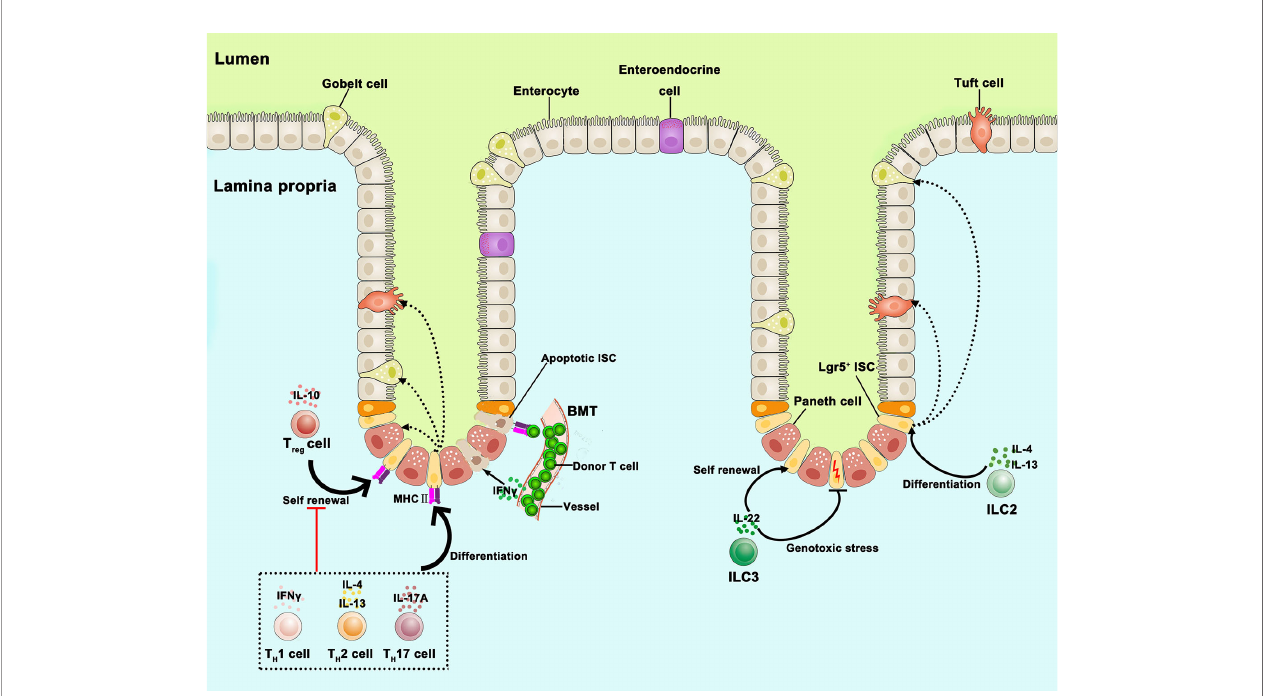
FIGURE 2 | The link between the intestinal stem cells and immune cells. The role of immune cells such as T cells and ILCs, as well as cytokines secreted by these immune cells on the regulation of ISC function. T reg cells (IL-10) promote ISC renewal, while T H 1 (IFN g ), T H 2 (IL-4, IL-13), and T H 17 cells (IL-17A) suppress ISC renewal and promote differentiation; T H 1(IFN g ) and T H 2 (IL-4, IL-13) cells promote speci fi c differentiation toward Paneth cells and tuft cells, respectively; donor T cells (IFN g ) act on ISC by triggering apoptosis in GVHD; MHCII is important for interactions between ISC and T cells. ILC2s (IL-4, IL-13) promote speci fi c differentiation toward goblet cells and tuft cells; ILC3s (IL-22) promote ISC proliferation through STAT3 signals; protect ISC against genotoxic stress. IL, interleukin; IFN g , interferon g ; ISC, intestinal stem cell; ILC, innate lymphoid cell; T H , T helper; T reg cells, regulatory T cells; GVHD, graft versus host disease, MHCII, major histocompatibility complex II; STAT3, signal transducer, and activator of transcription